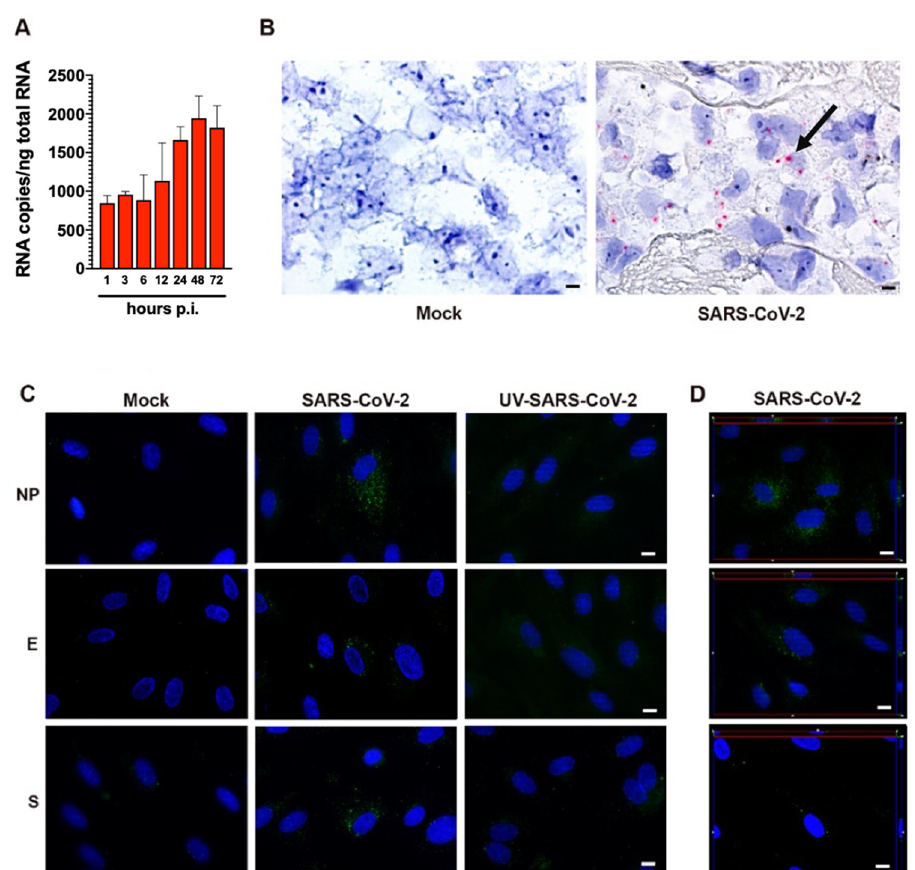
Figure 2. SARS-CoV-2-infected HL-mECs express viral RNA and proteins. ( A ) Quantitation of SARS-CoV-2 genomes at the intracellular level by qRT-PCR. At least three replicates were performed. Data are representative of two independent experiments with similar results. ( B ) SARS-CoV-2 RNA in situ hybridization using the S antisense probe shows strong expression of viral RNA as red cytoplasmic dots in SARS-CoV-2-infected HL-mECs (black arrow), while mock-infected cells (Mock) are negative (scale bar, 3 µ m). ( C ) HL-mECs were mock-infected (Mock) or infected with SARS-CoV-2 (SARS-CoV-2) or with UV-inactivated SARS-CoV-2 (UV-SARS-CoV-2) at MOI 1, for 1 h at 37 ◦ C, then washed and cultured until day 3 p.i. Immunofluorescence was performed by incubating cells with antibodies targeting the SARS-CoV-2 NP (upper panels), E (middle panels), or S (lower panels) proteins (scale bar, 10 µ m). ( D ) z-Stack sections and orthogonal z reconstitution of SARS-CoV-2-infected HL-mECs expressing NP, E, or S proteins (scale bar, 10 µm). Images of HL-mECs display SARS-CoV-2 signals in green and cell nuclei in blue.